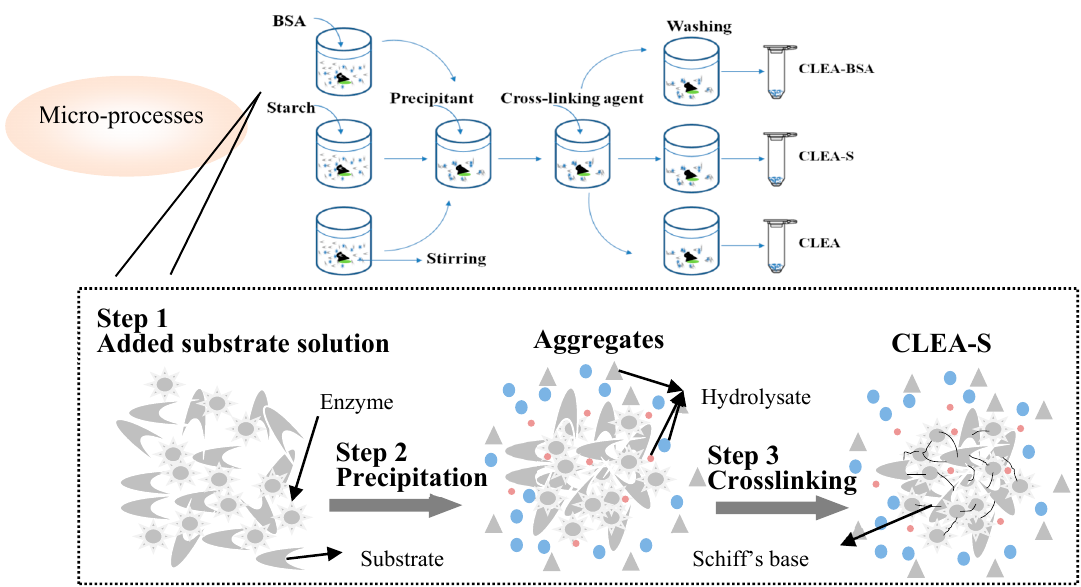
Figure 1. Schematic illustration of the preparation of α -amylase-prepared as crosslinked α -amylase aggregate with starch (CLEA-S).